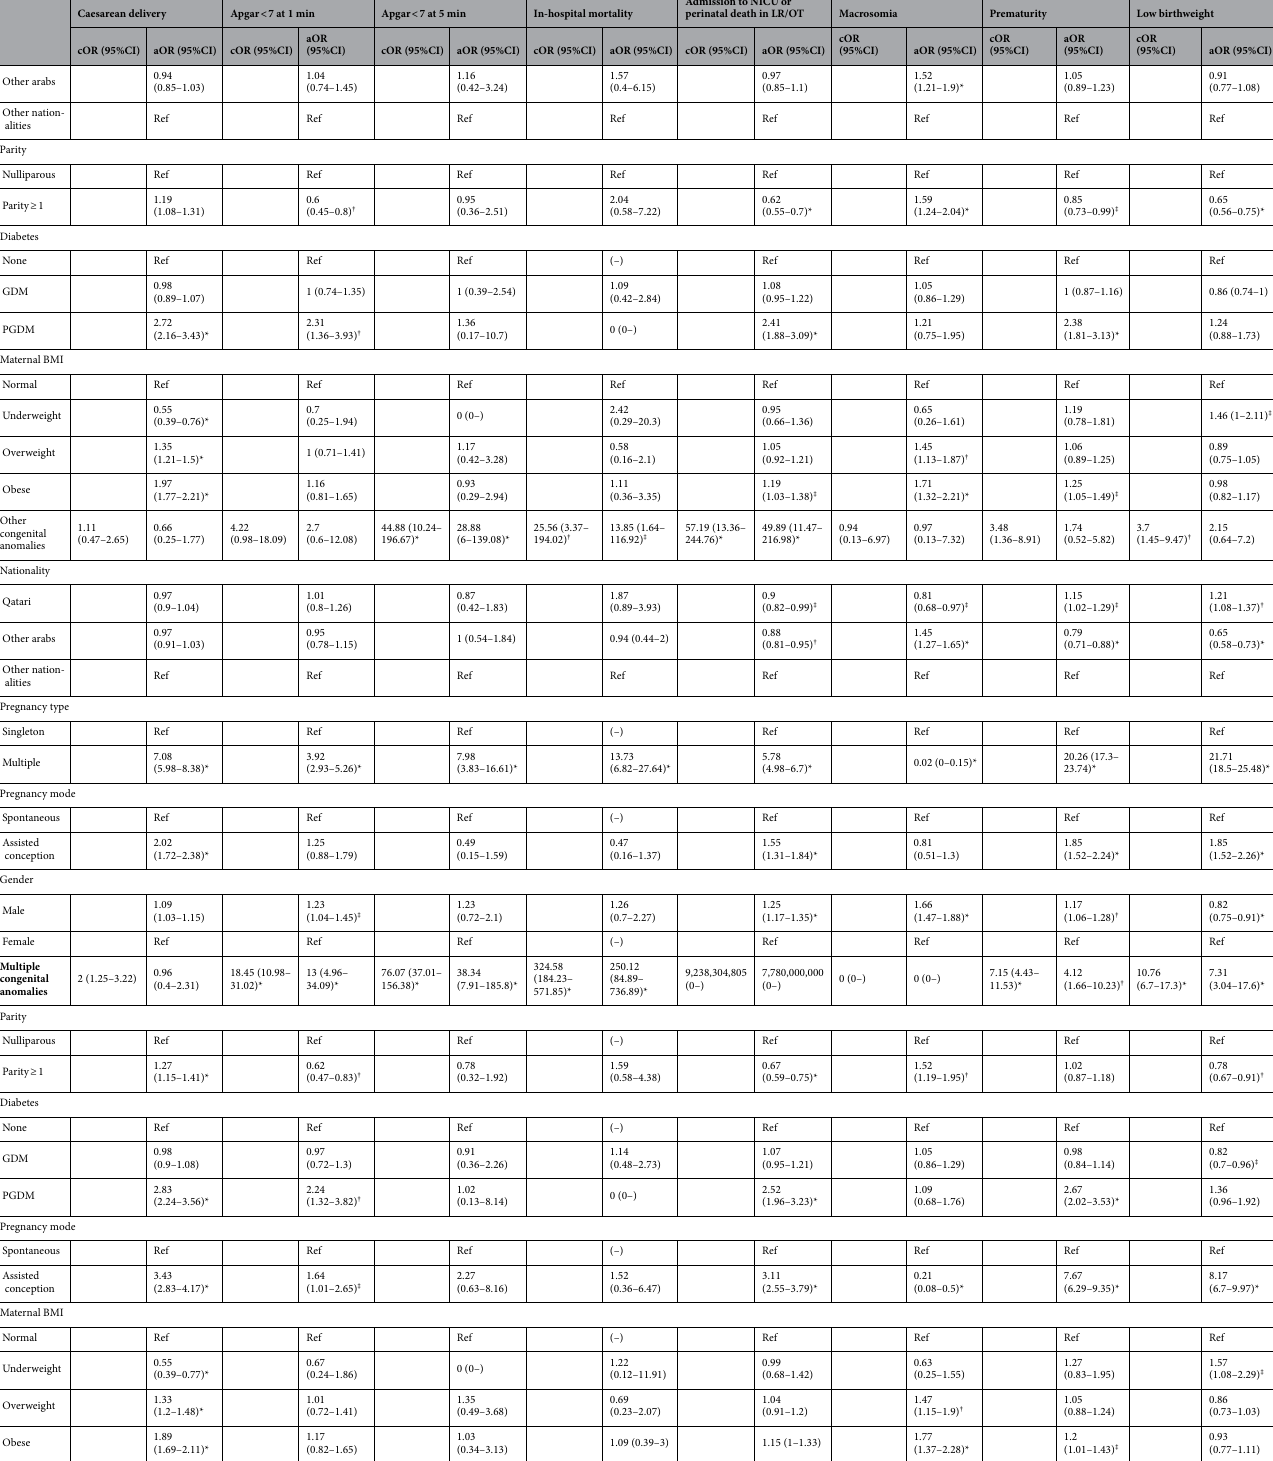
Table 3. Pregnancy outcomes of the overall study population according to the presence of congenital anomalies. CNS central nervous system; CVS cardiovascular system; others: gastrointestinal, respiratory, urogenital, and skeletal; multiple: two or more anomalies; GDM gestational diabetes mellitus; PGDM pregestational diabetes mellitus; NA not applicable. *p < 0.001; † p < 0.01; ‡ p <